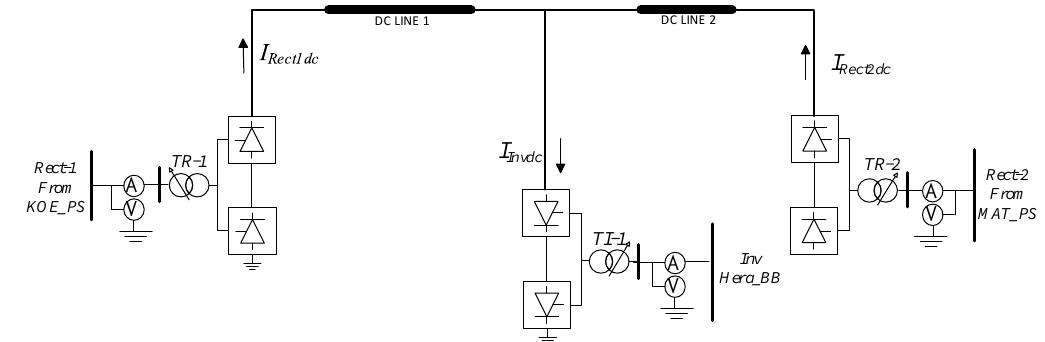
Figure 4. Three-terminal LCC HVDC topology.